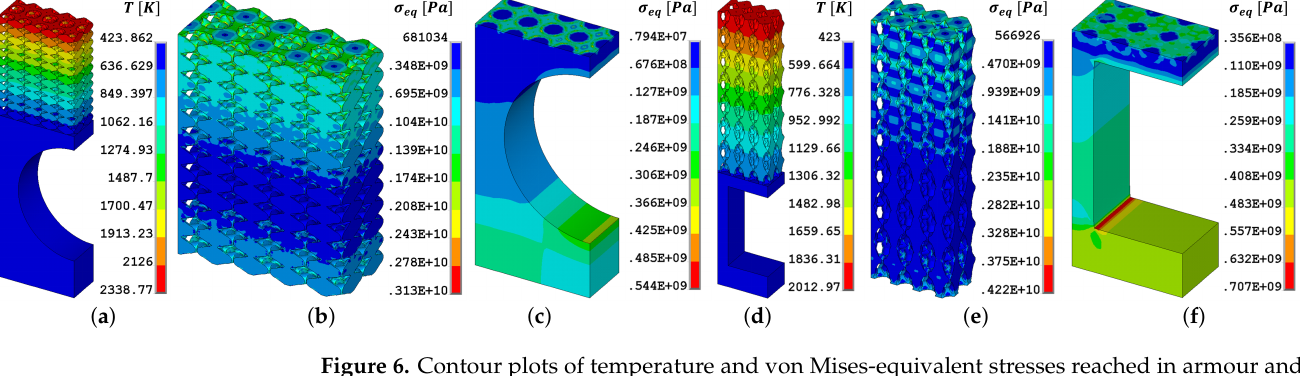
Figure 6. Contour plots of temperature and von Mises-equivalent stresses reached in armour and heat sink at the most critical time of the ramp-down phase for ( a – c ) Configuration 1 and ( d – f ) Config- uration